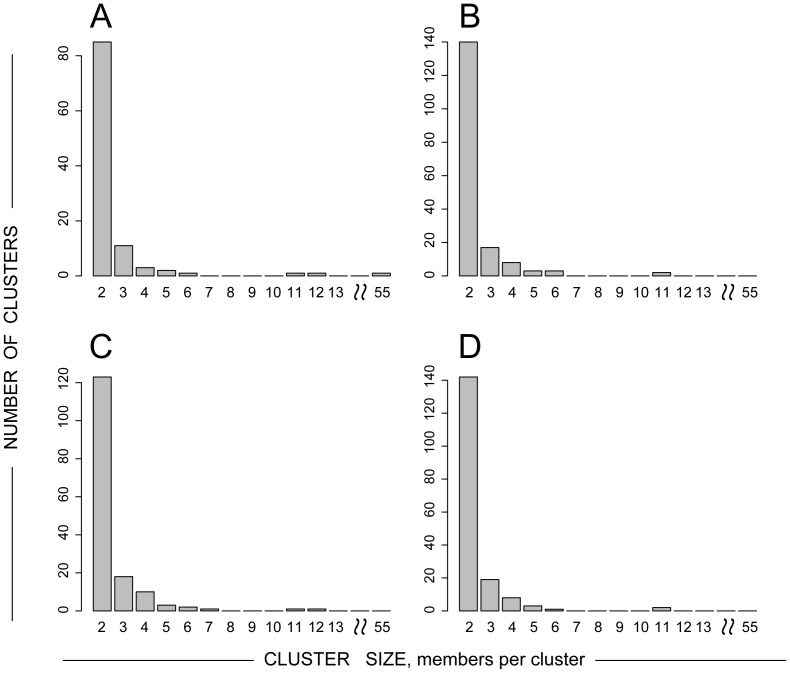
The uniform cluster size distribution followed the power law.Axis x shows cluster size as the number of members per cluster. Axis y shows the number of identified clusters. A: MLFastTree2. B: MLFastTree2 + MLPhyML. C: MLFastTree2 + MLRAxML. D: MLFastTree2 + MEMCL. Note: The cluster with 55 members was identified in the MLFastTree2 analysis only, and was not confirmed in the second-step analysis by the ML or ME phylogeny.